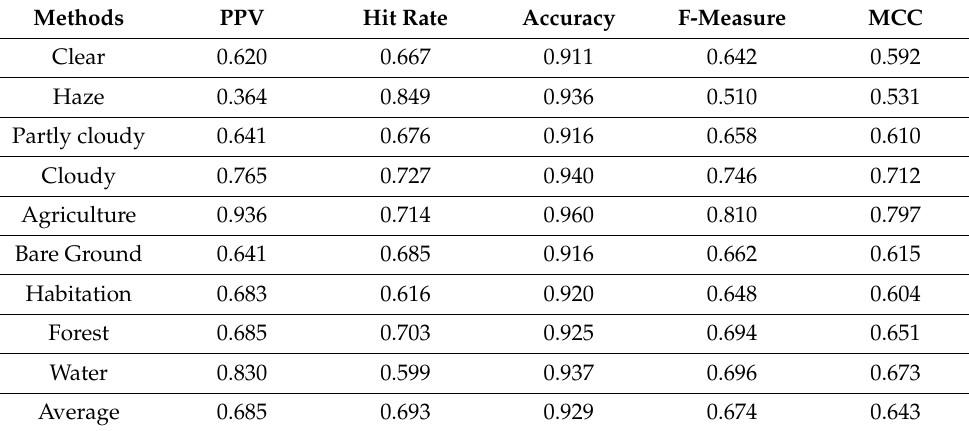
Table 4. Result analysis of ensemble model with different measures.